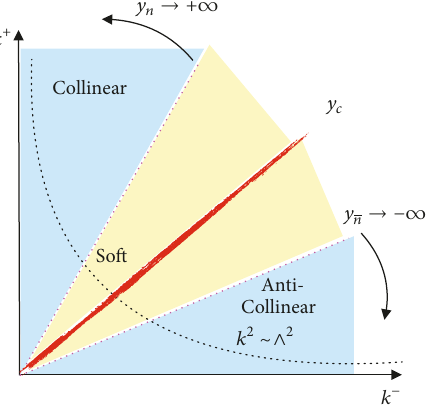
Figure 1: Diagrams of regions for TMD factorization (original figure in